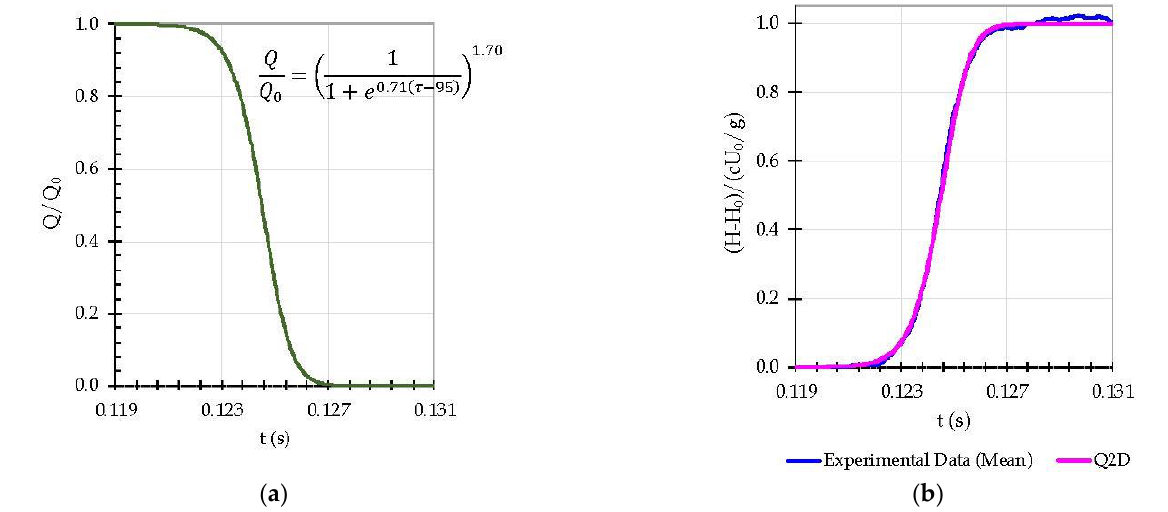
Figure 4. Calibrated valve maneuver for laminar flow: ( a ) Q2D model flow rate variation; ( b ) experimental and Q2D model piezometric head variation.